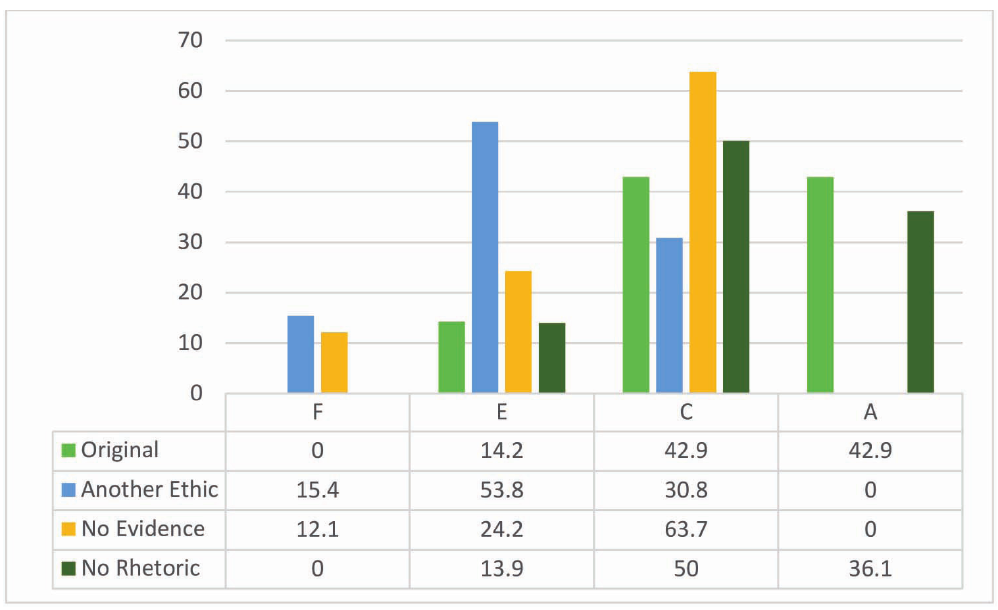
Figure 1: Grades awarded to each response